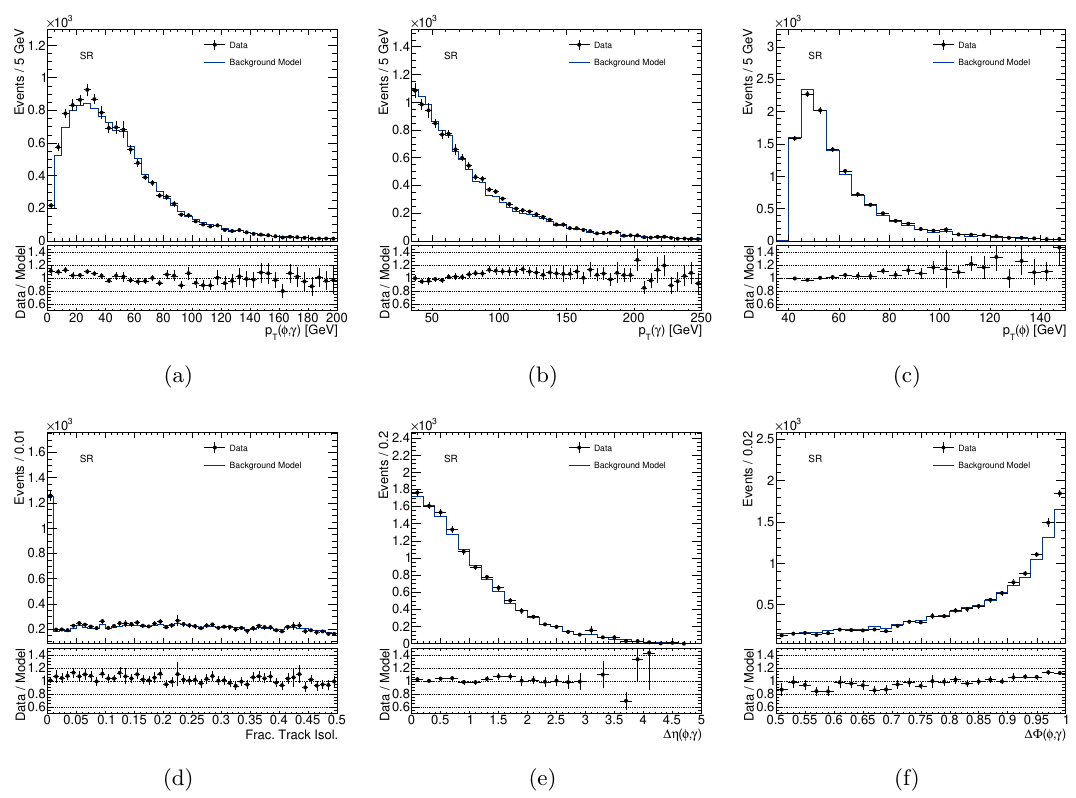
Figure 3 . Distributions of kinematic and isolation variables in the SR, for the simulated data and background model.